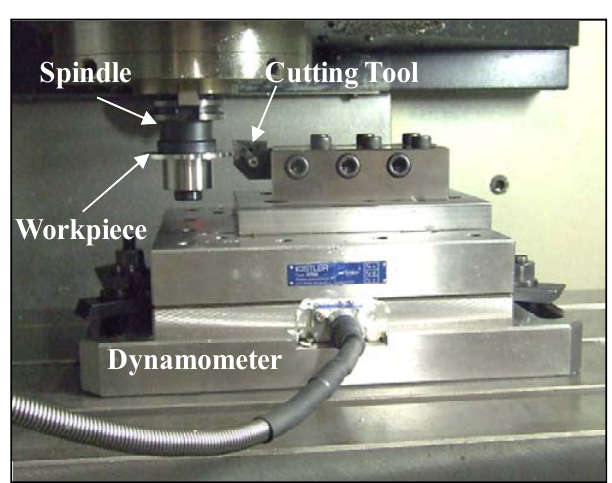
Figure 23. Orthogonal machining